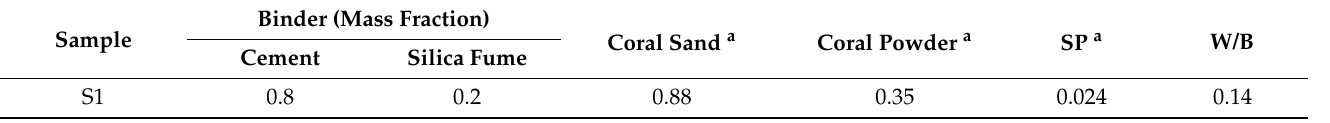
Table 4. The original mix